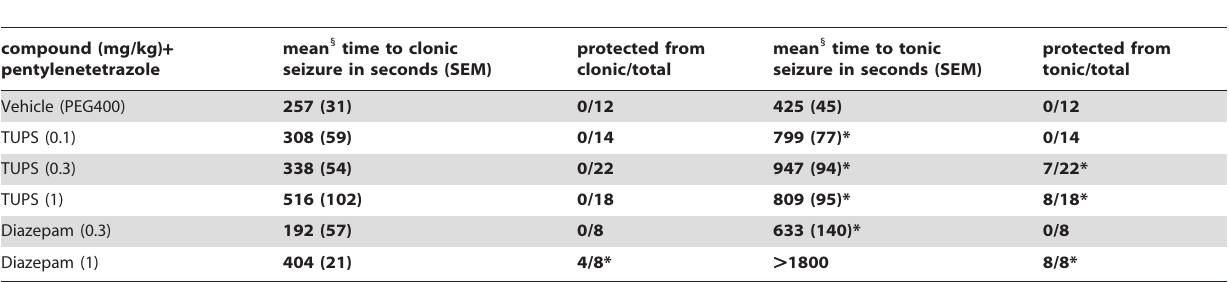
Table 1. The sEHI treatment reduced the proportion of mice experiencing tonic seizures but did not provide significant protection against clonic